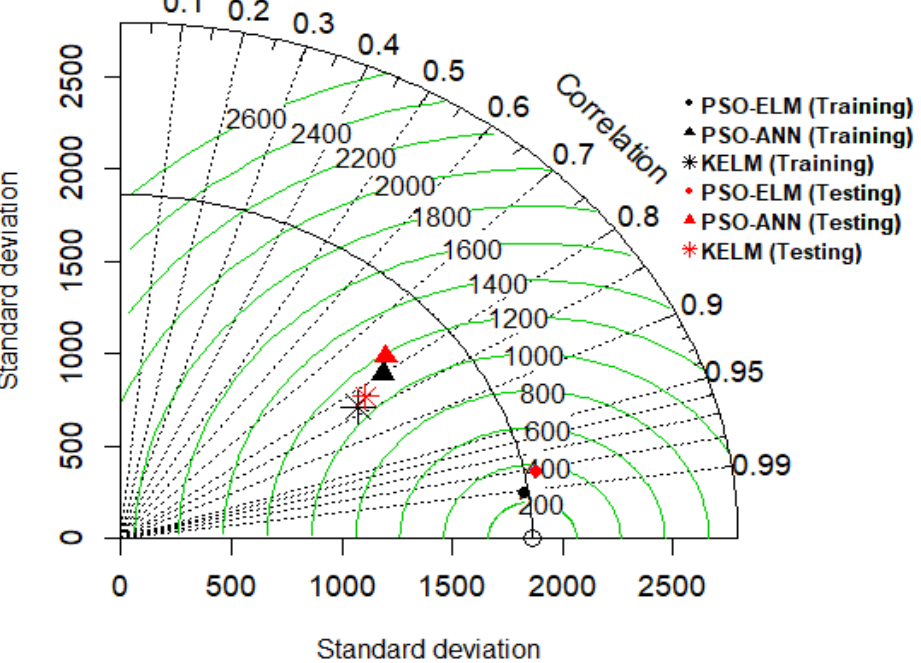
Figure 4. Statistical Taylor diagram for comparative study of the three investigated models during training and testing phases.